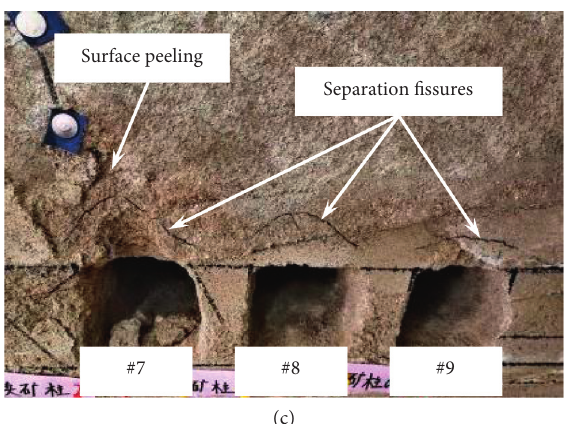
Figure 6: Failure characteristics of underground stope after (a) first-stage excavation, (b) second-stage excavation, and (c) third-stage excavation under the model of slope height of 200 m and slope angle of 65 °